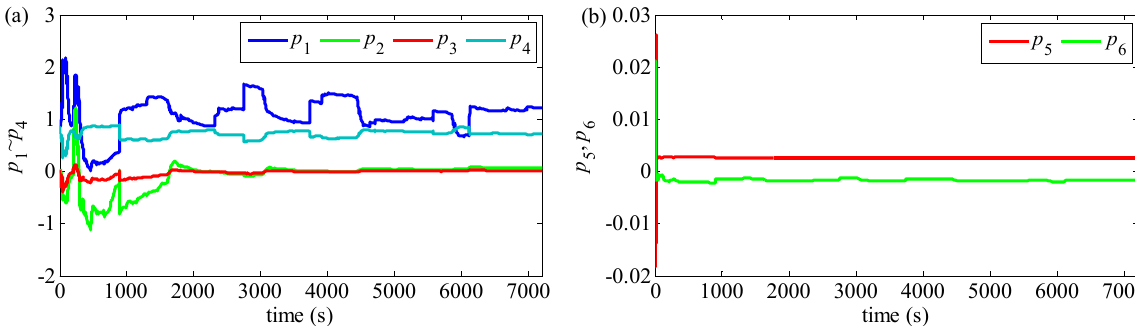
Figure 5. Online parameters identification results of the EP model and calculated